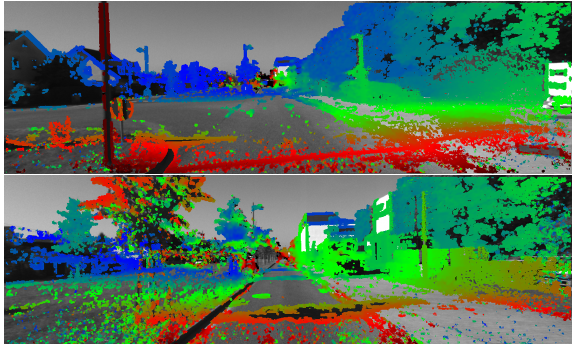
Figure 2. Instablitiy of non-robustified C-LSD-SLAM on se- quence 06 of the KITTI odometry challange. Distance estimates of the depth maps are colored from blue (far) over green to red (near). The upper image shows invalid distance estimates ap- pearing near the epipolar direction, which then propagate mainly to the left. The lower image shows the situation several frames later. Here, invalid distance estimates have overtaken a large part of the image, causing tracking divergence several frames